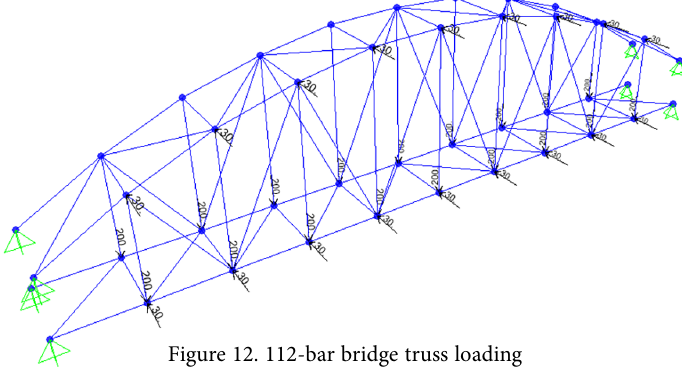
Figure 11. 112-bar bridge truss